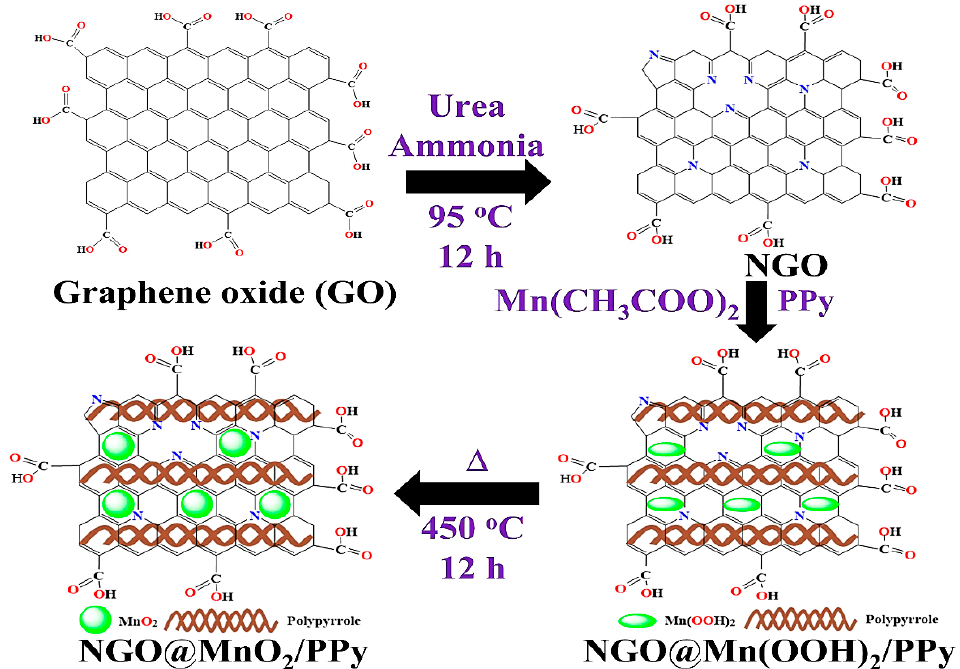
Figure 1. The synthesis process of NGO@MnO 2 /PPy.